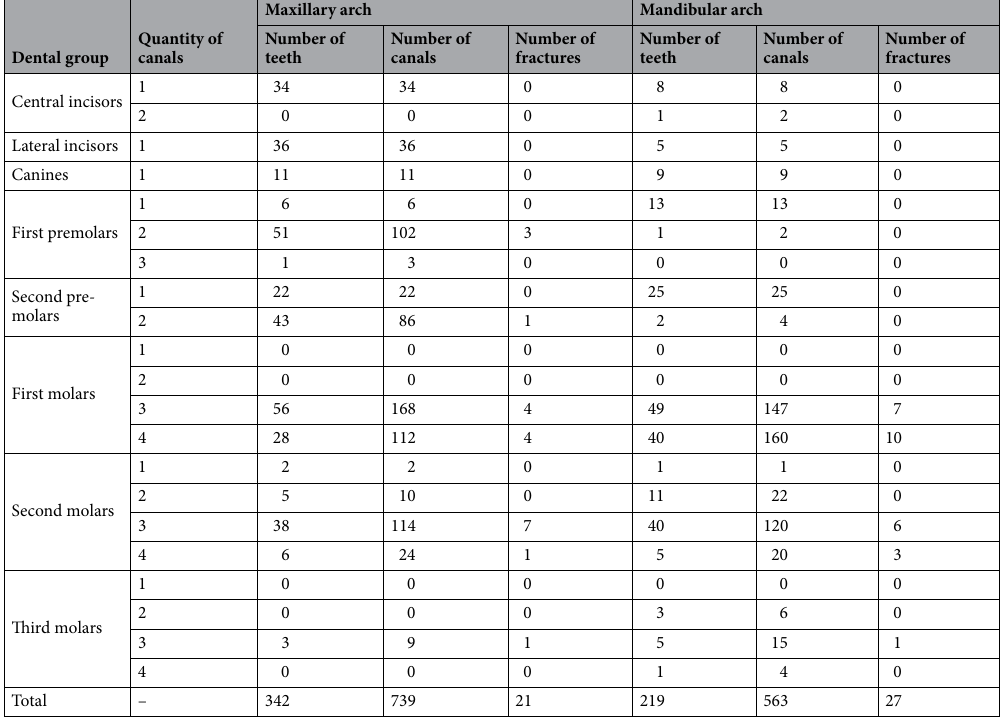
Table 2. Number of teeth, canals, and fractures per arch.